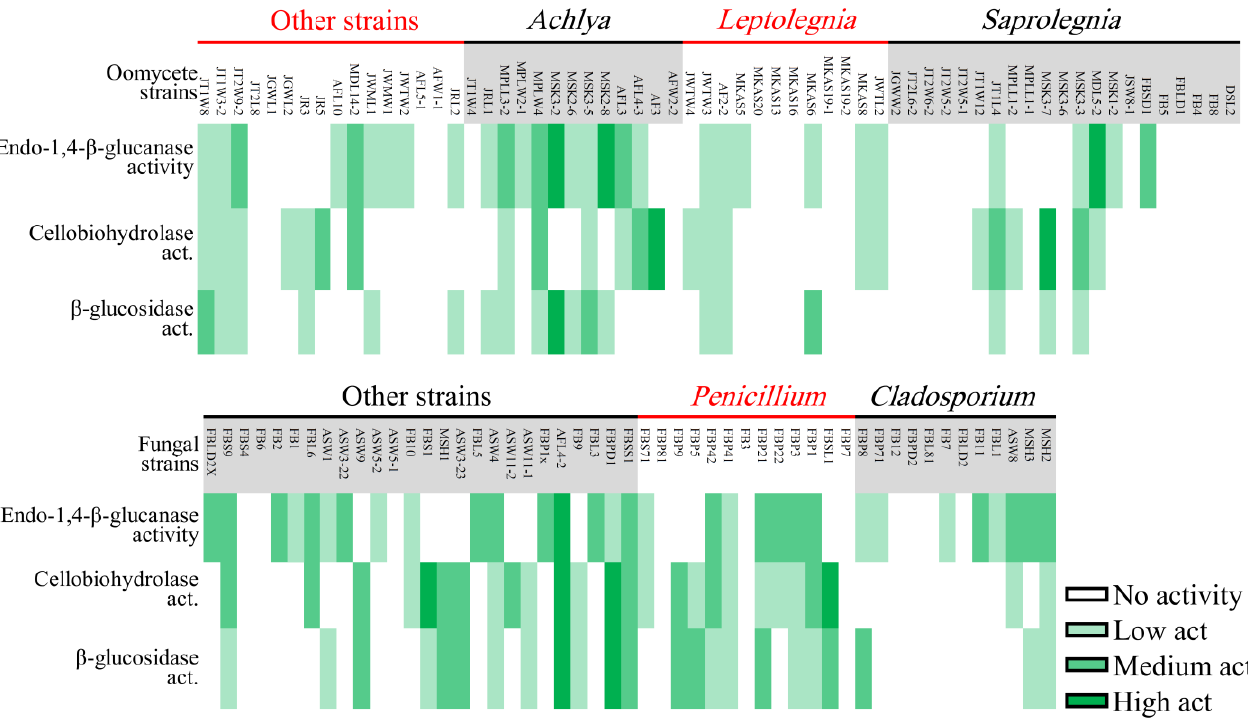
Figure 6. Heatmap showing cellulolytic activity of oomycete ( upper ) and fungal ( lower ) strains isolated in this study.